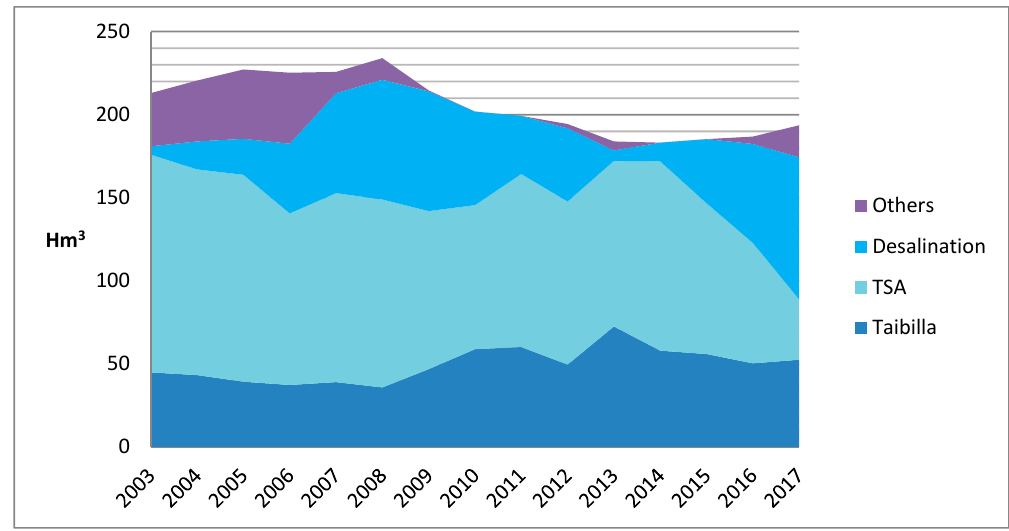
Figure 5. Supply sources of the MCT (hm 3 ) (2003–2017). Source: Mancomunidad de los Canales del Taibilla [40]. Own elaboration.